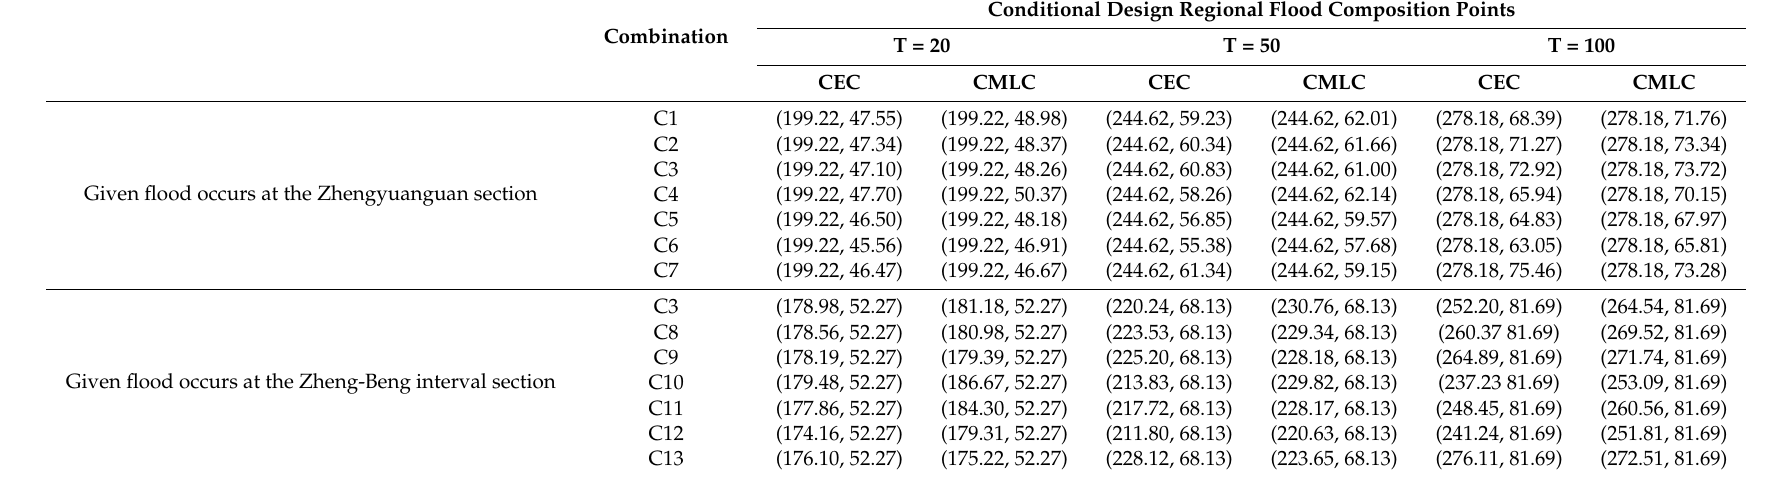
Table 6. CEC and CMLC points under different combinations of marginal